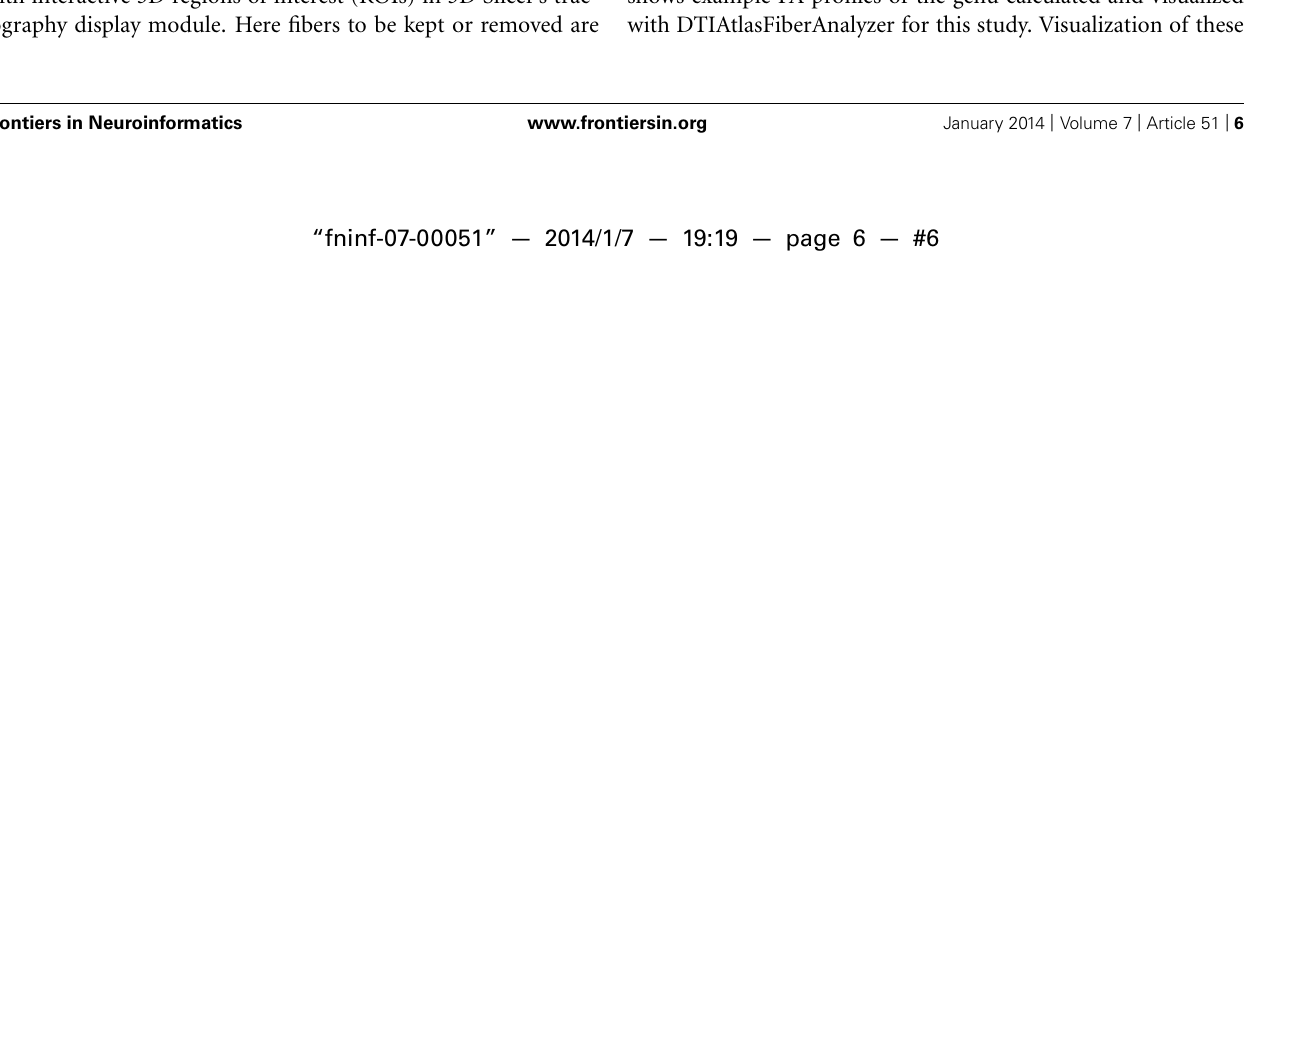
selected using ROIs iteratively. ROIs should also be utilized